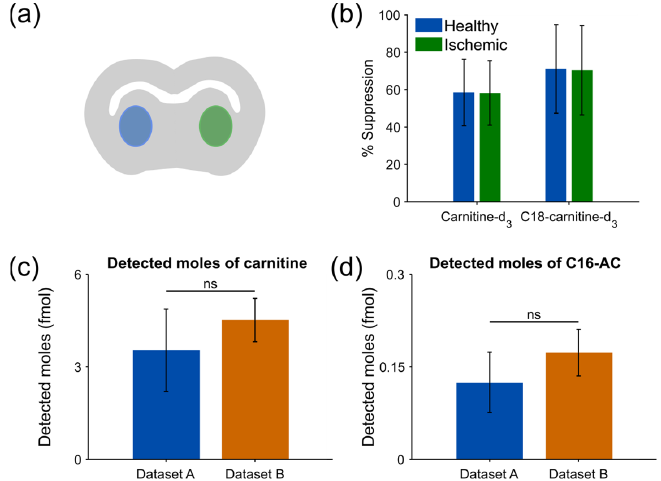
Figure 1. Comparison of ion suppression and quantitative assessments. ( a ) Schematic of a mouse brain tissue section where the healthy area is depicted as blue and the ischemic as green. ( b ) Ionization suppression (%) of C-d3 and C18-AC-d3 between healthy and ischemic tissue regions. ( c ) Detected moles of carnitine in the healthy region from dataset A and B using Equation (2). ( d ) Detected moles of C16-AC in the healthy region from dataset A and B using Equation (2). The error bars in ( b ) represent the propagated error due to the standard deviation of each scan in Equation (1).